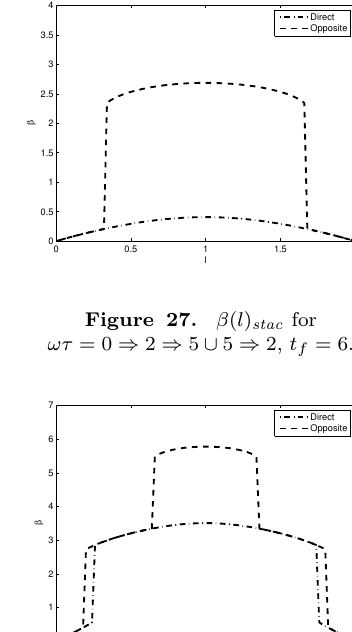
Figure 29. β ( l ) stac for ωτ = 0 ⇒ 6 ⇒ 8 ∪ 8 ⇒ 6, t f =